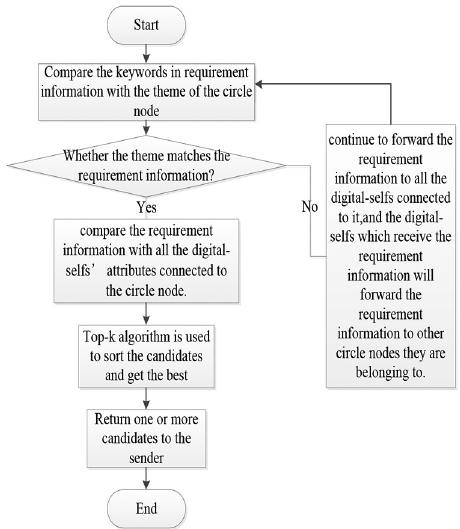
Figure 7. The algorithm fl ow of the provision-demand matching